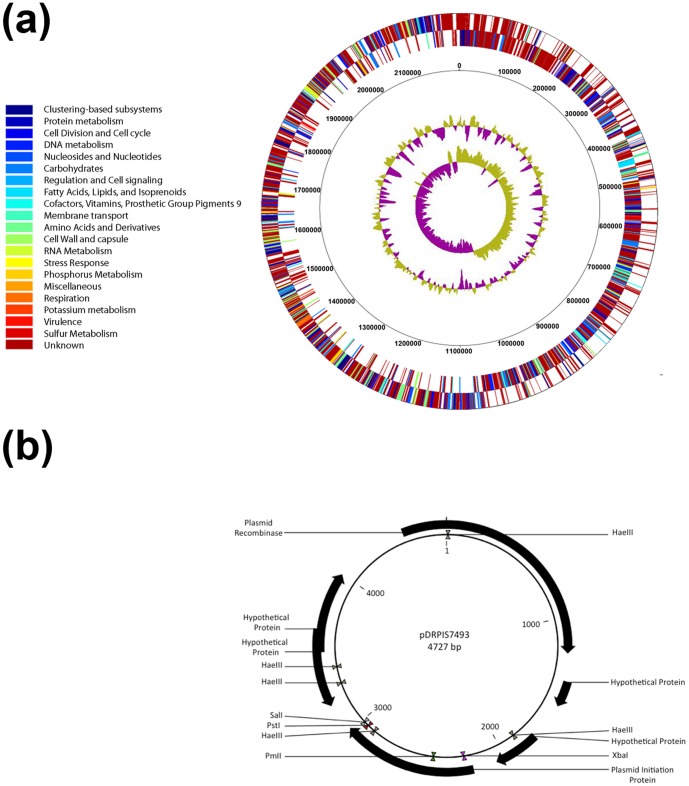
Overview of the genome of S.
pseudopneumoniae IS7493.(a) Representation of the S. pseudopneumoniae IS7493 circular genome. The inner circles represent GC content (outer) and GC bias (innermost). (b) Full assembly revealed the presence of plasmid pDRPIS7493.